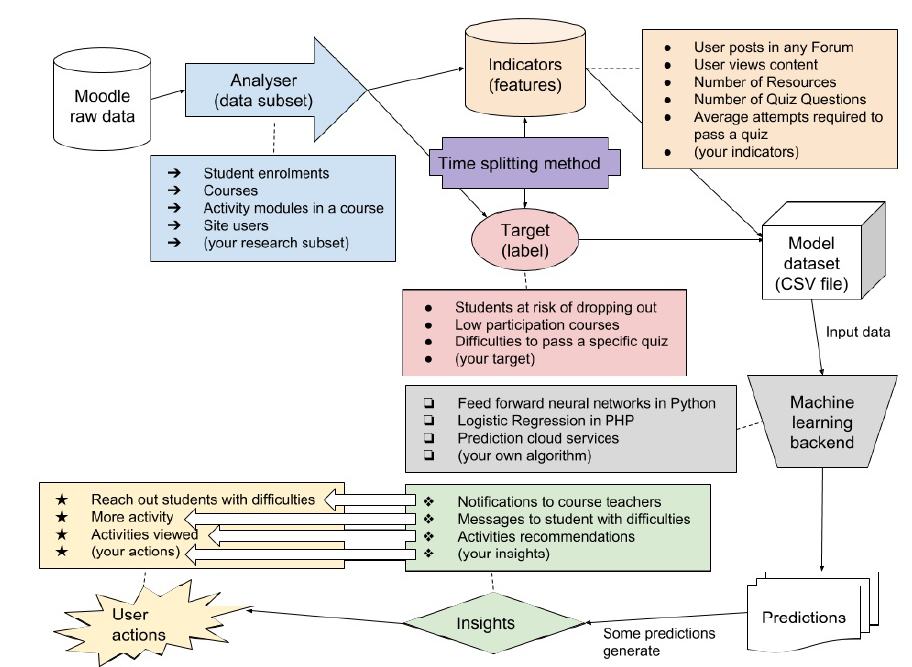
Fig. 1 Forecast model algorithm flow